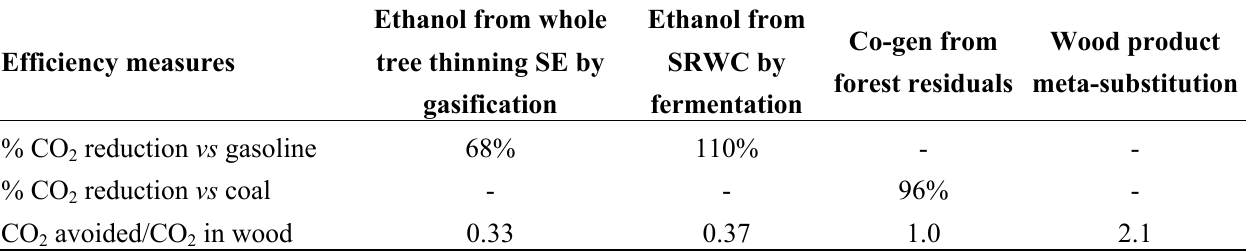
Table 1. Processing efficiency